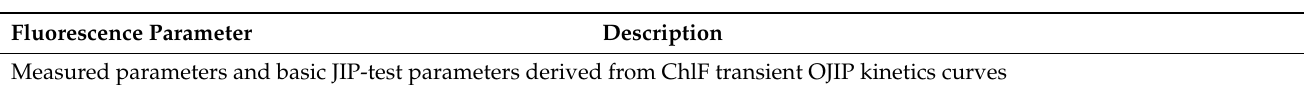
Table 2. Definition of terms and formulae for calculation of JIP-test parameters from chlorophyll a fluorescence (ChlF) transient OJIP kinetics